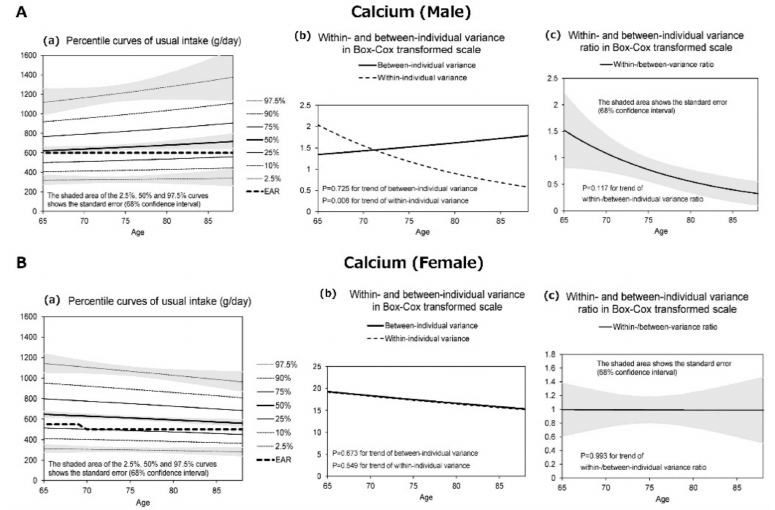
Figure 4. The percentile curves of usual nutrient intake of calcium by age (male and